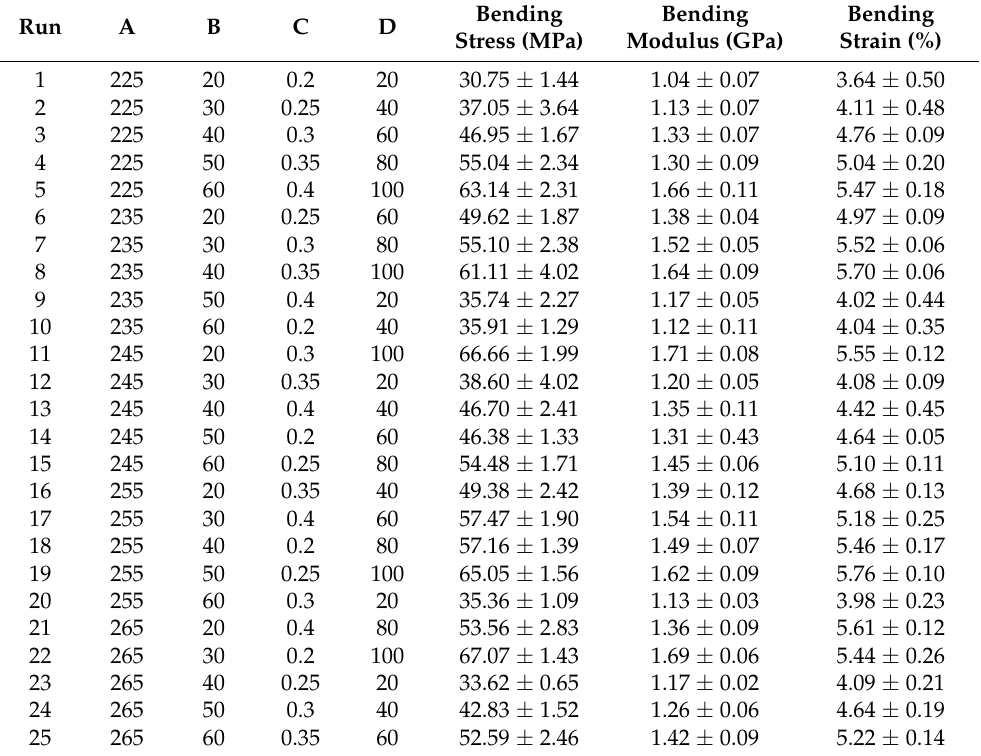
Table 4. Bending experimental results detailed obtained using Taguchi L16 (4 5 ) for PETG.